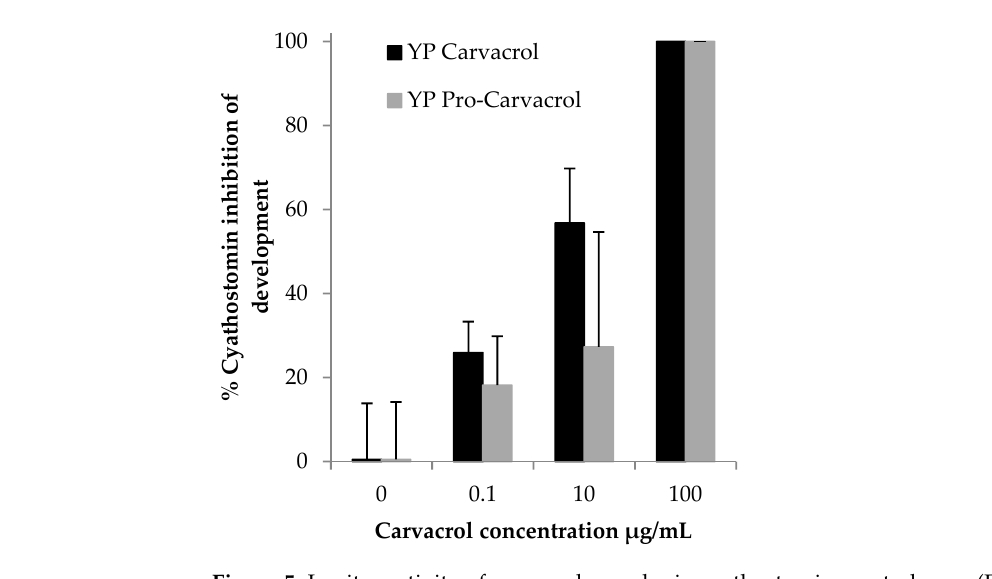
Figure 5. In vitro activity of carvacrol samples in cyathostomin egg-to-larvae (E2L) assay. YP pro-terpene and YP terpene samples were evaluated at a concentration of 333 µ g terpene/mL in the adult hookworm and whipworm assays. We previously identified all four terpenes to have a fast-acting effect on hookworm at the selected terpene concentra- tion of 333 µ g /mL [22]. We also demonstrated that hookworms readily ingest YPs which leads to two possible mechanisms of terpene entry: (1) hookworm ingestion of terpene released from YPs or (2) hookworm ingestion of YP terpene or YP pro-terpene and subse- quent terpene release inside the worms. The results in Figure 6 show that all samples were active against hookworm after 2-h and 24 h incubation and YP+EDTA control was non- toxic.